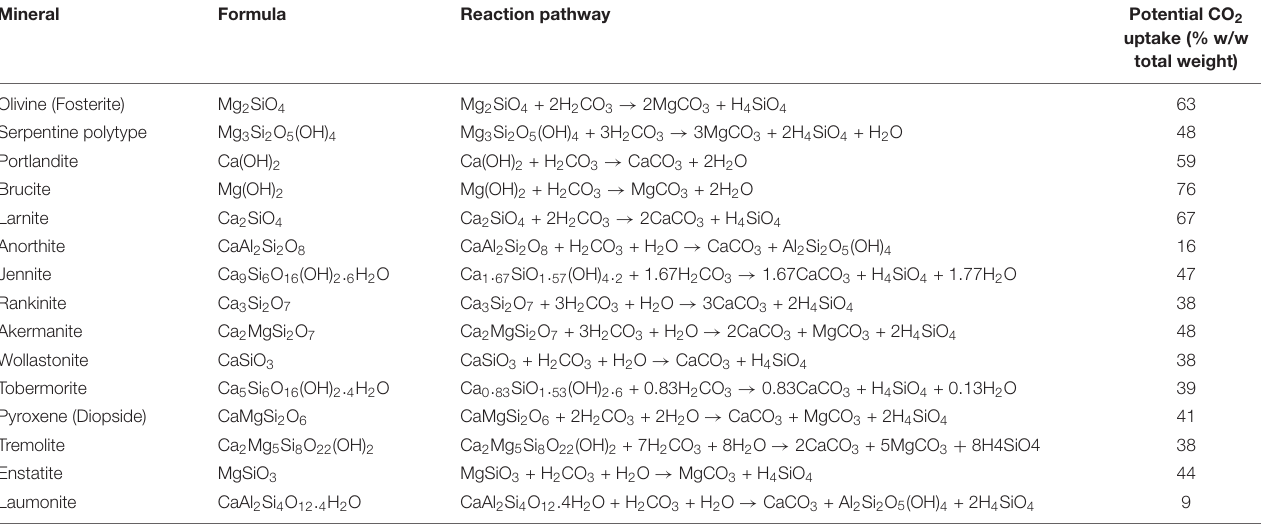
TABLE 1 | Common minerals and their reactivity with carbon dioxide. Mineral Formula Reaction pathway Potential CO 2